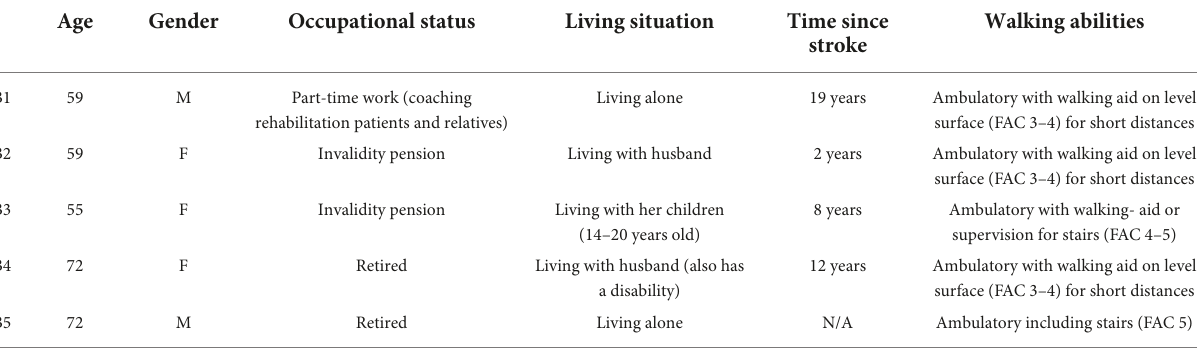
TABLE 1 Participant